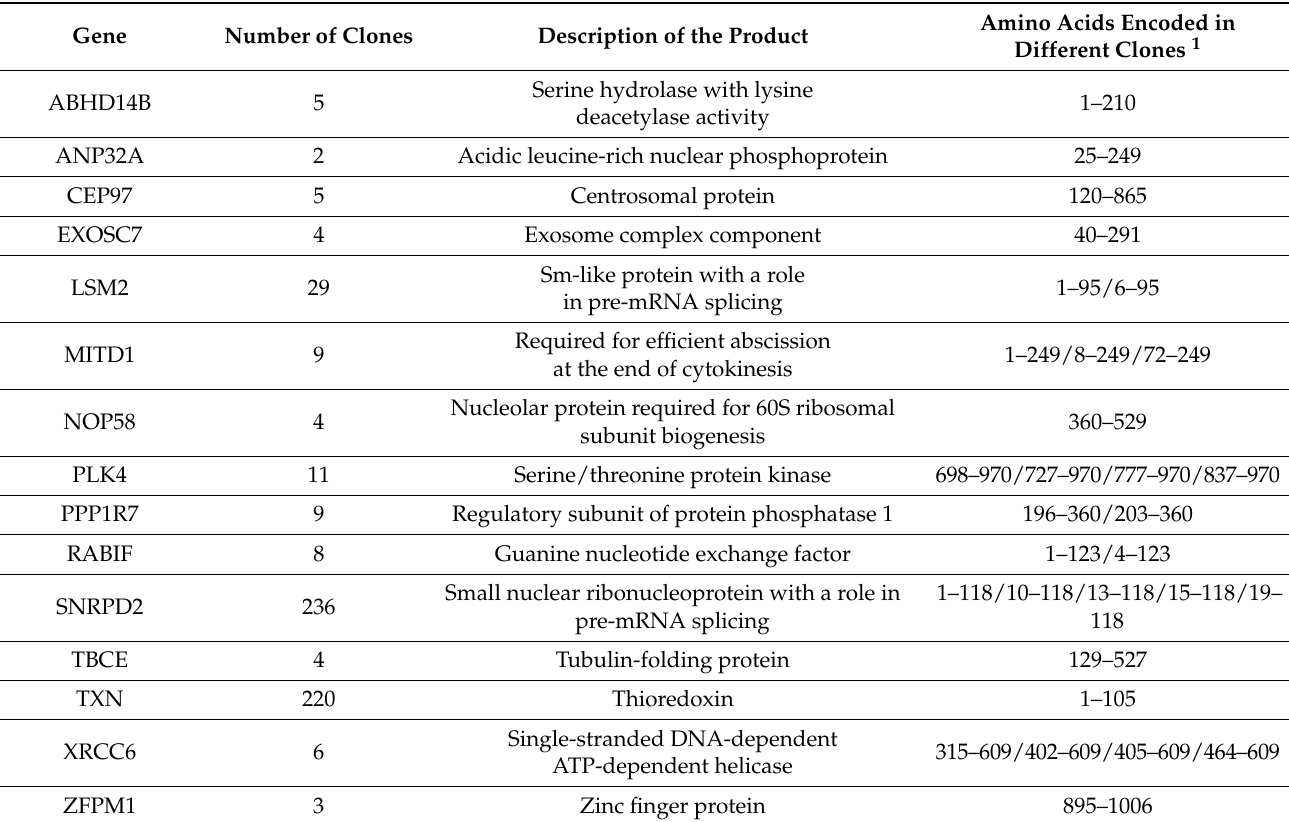
Table 3. Candidate host partners of SlrP identified in a yeast two-hybrid